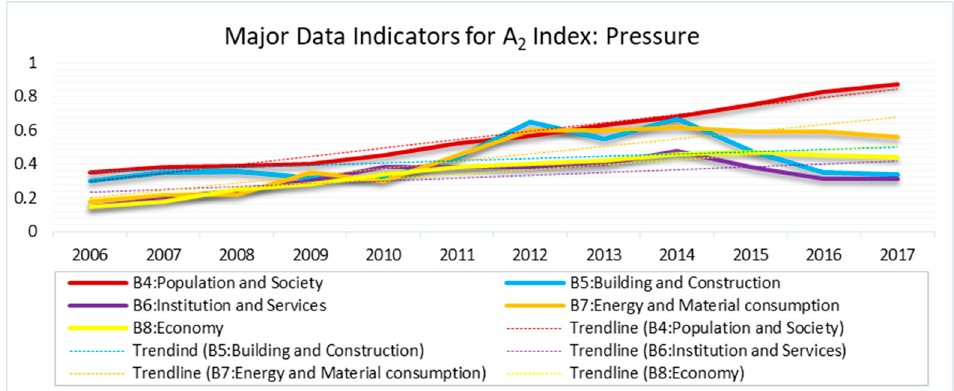
Figure 3. Major Data Indicators for A 2 Index: Pressure.